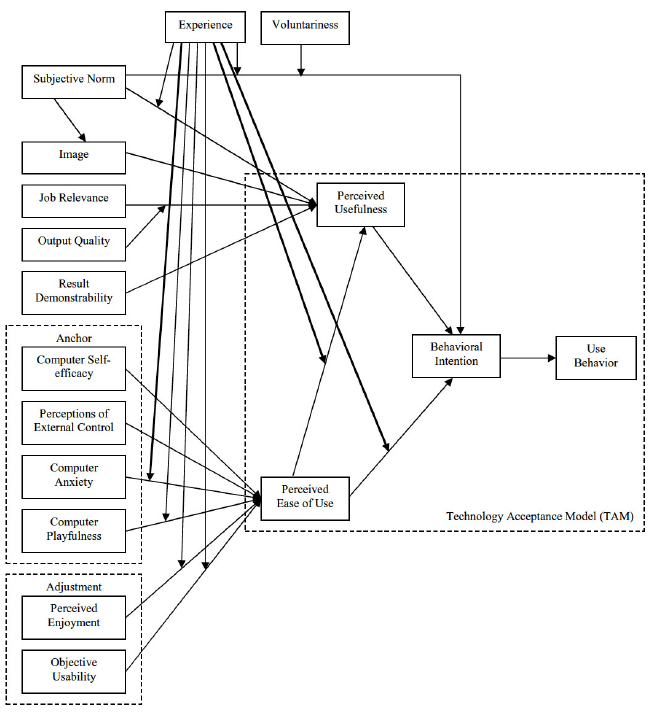
Fig. 5. Technology Acceptance Model